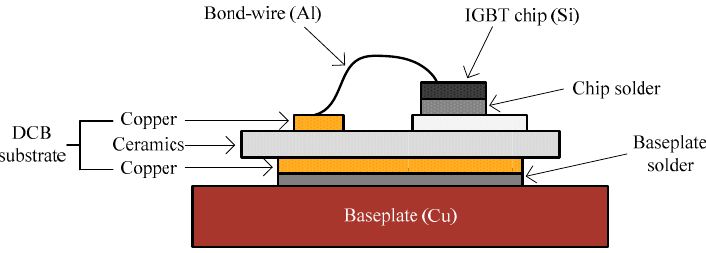
Figure 1. Configuration of the standard insulated-gate bipolar transistor (IGBT) module [17].